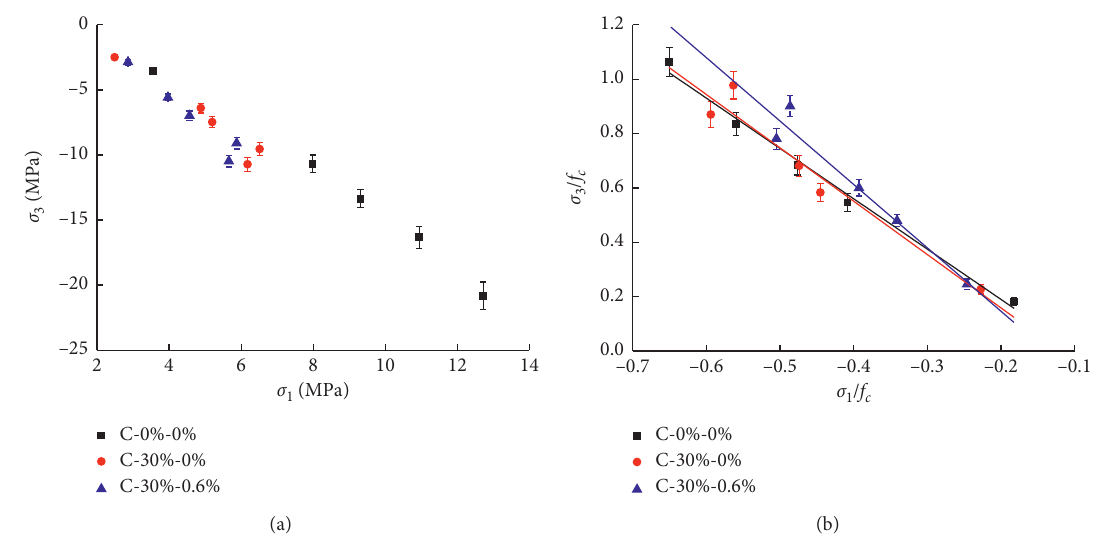
Figure 13: The relationship between the first principal stress and the third principal stress of rubber fiber concrete. (a) The first principal stress and the third principal stress. (b) The first principal stress ratio and the third principal stress